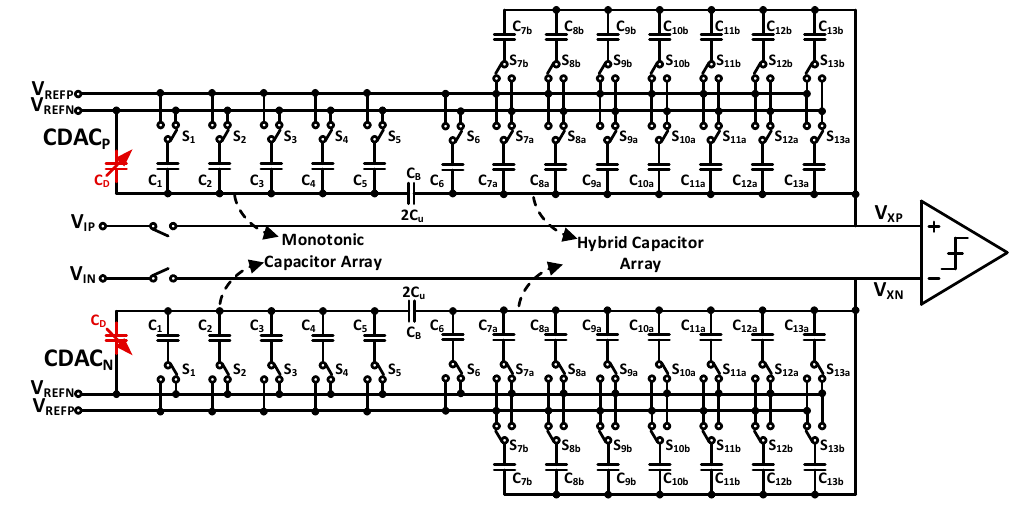
Figure 3. The proposed split CDAC.